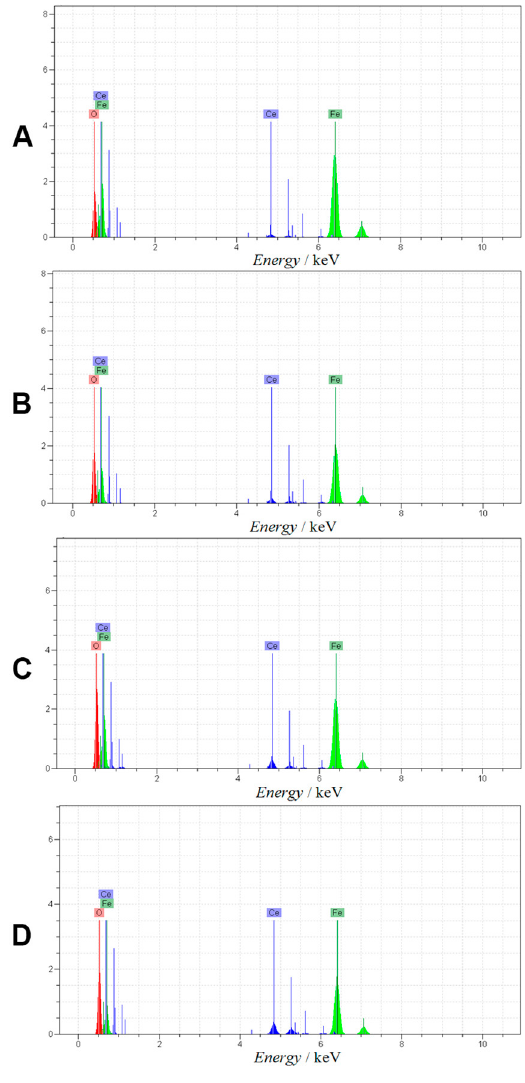
Figure 7. EDX analysis of steel samples coated at different immersion times in cerium chloride solution: (a) 20 s, (b) 40 s, (c) 60 s, and (d) 120 s.